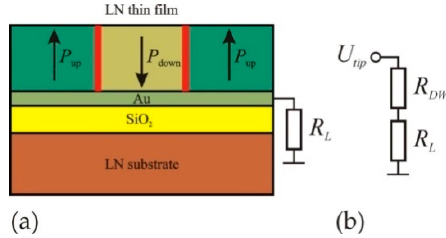
Figure 1. The schematic presentation of a domain written by AFM-tip voltage in LNOI ( a ) and the equivalent circuit of the domain writing ( b ). In ( a ) the red vertical lines represent DWs, the horizontal green and yellow layers show the metal and SiO 2 ones, respectively; in ( b ) R DW is the DWs’ total resistance. In ( a , b ) R L is the load resistor.